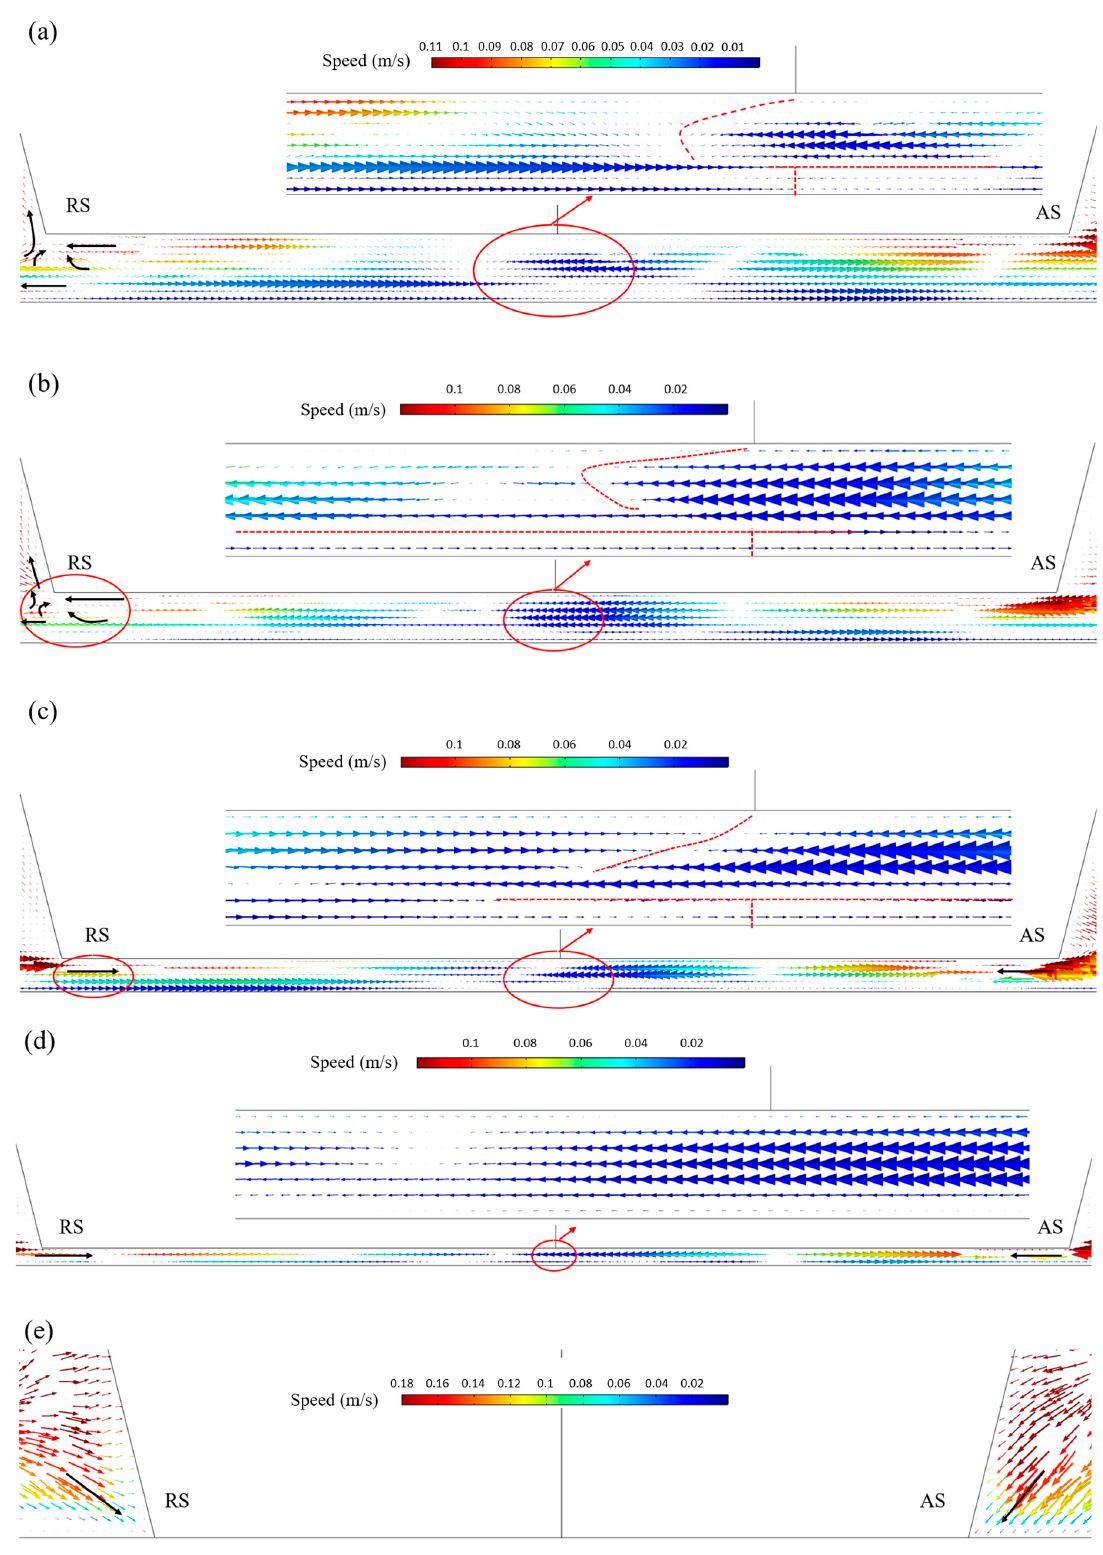
Figure 9. Effect of pin length on plastic metal flow at the root of the weld (1000 rpm, 120 mm/min). ( a ) 5.8 mm; ( b )5.85 mm; ( c ) 5.9 mm; ( d ) 5.95 mm; ( e ) 6.0 mm.